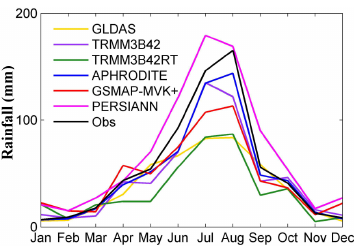
Figure 6. Inter-annual basin-averaged monthly precipitation.